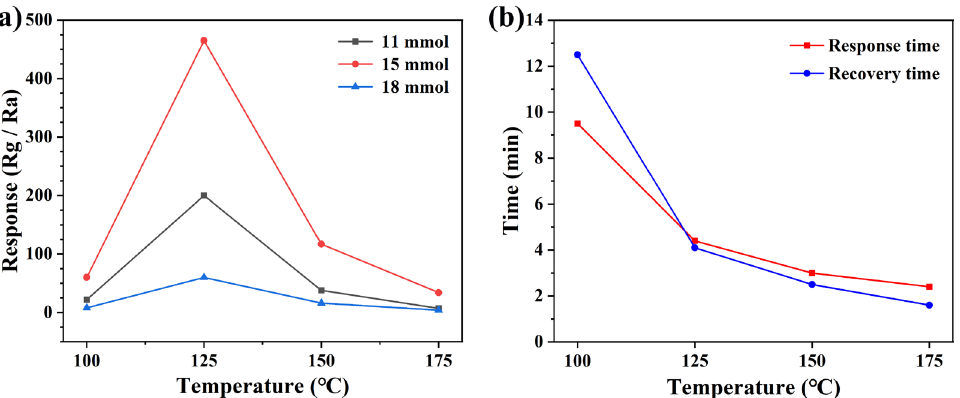
Figure 5. ( a ) Different sensors to 5 ppm NO 2 vs. operating temperatures, and ( b ) response-recovery times.